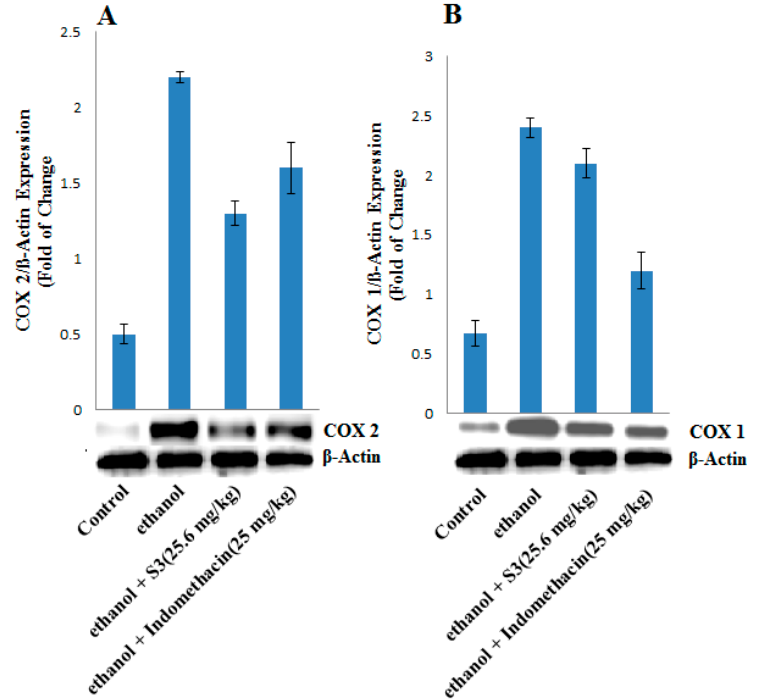
Figure 4. Western blot analysis of COX-2 ( A ), and COX-1 ( B ) expression in the rat gastric mucosa damaged by ethanol. The ethanol-administered rats showed marked increases in COX-2, and COX-1 expression in the gastric mucosa (a representative blot is shown). These increases were significantly suppressed by pre-treatment with compound S3 (25.6 mg/kg) or indomethacin (25 mg/kg), which were given 1 h before ethanol administration. Table 5. Docking of compounds ( S1 – S18 ) into COX-2 with reference drug indomethacin. Compd. No.